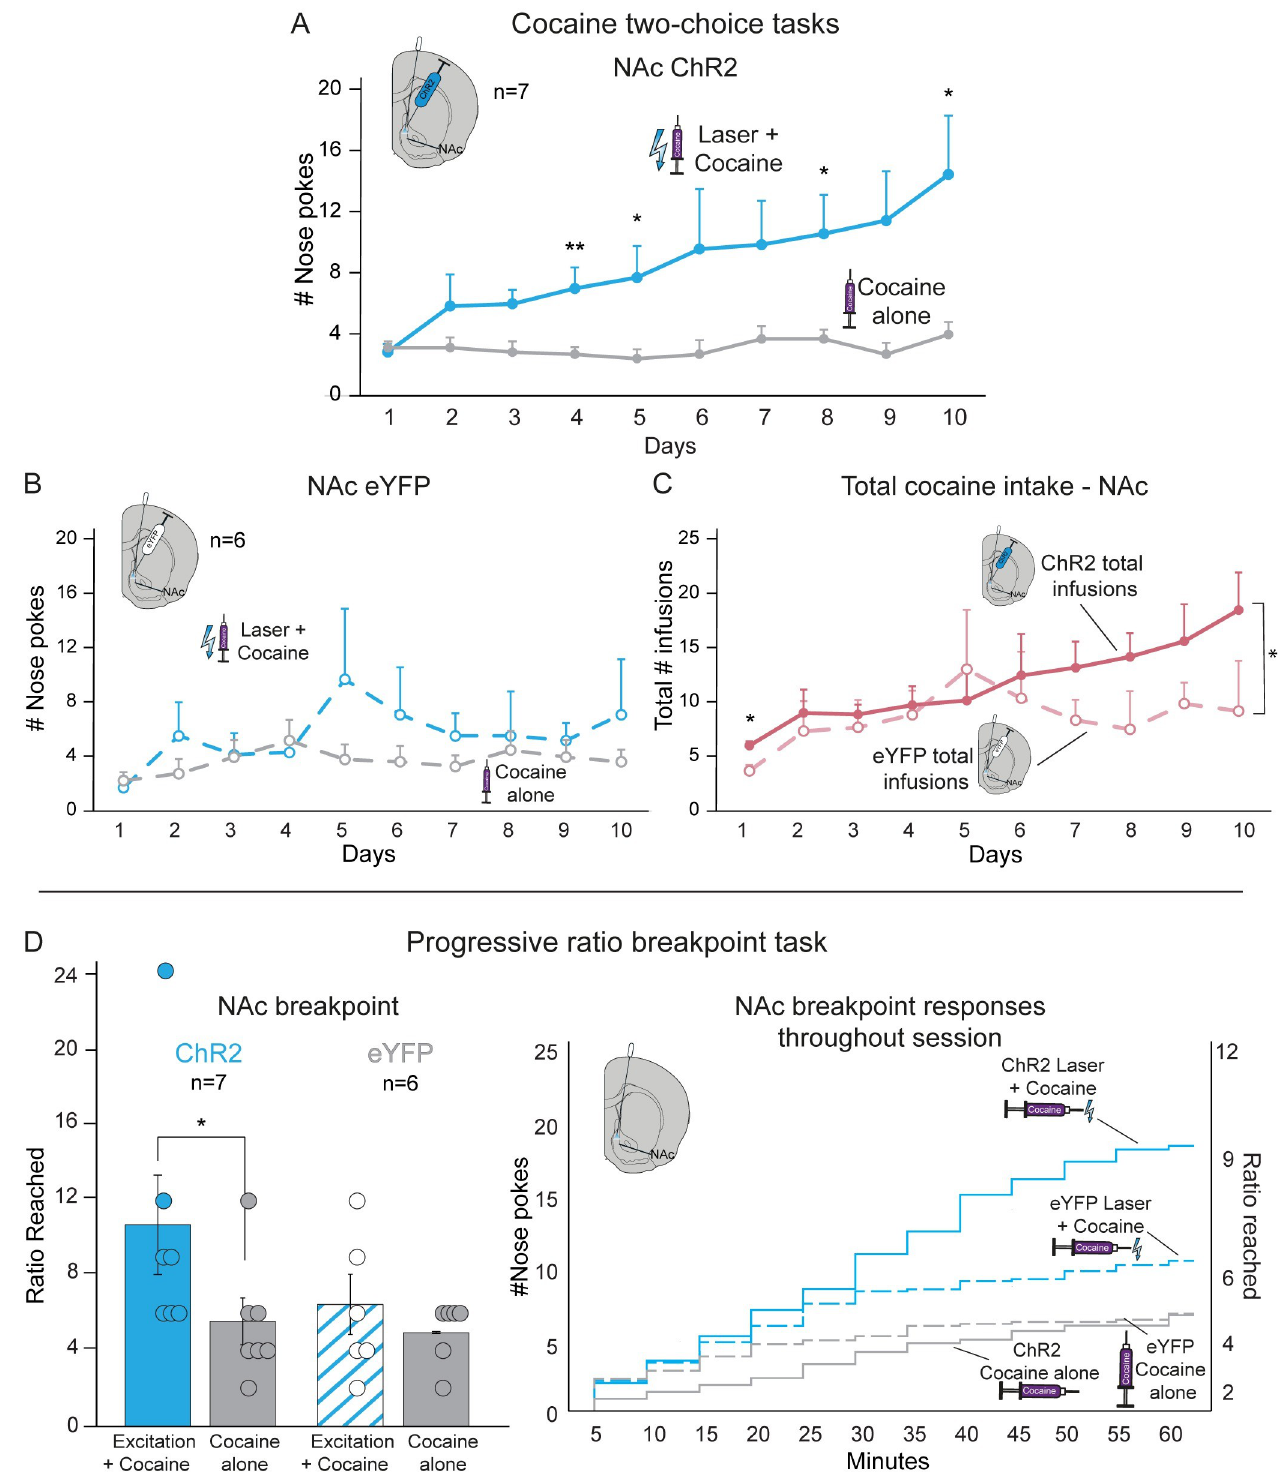
Fig 4. NAc ChR2 stimulation of CRF-containing neurons amplifies motivation and focuses preference on laser-paired cocaine. A) In the two-choice task, ChR2 excitation of CRF-containing neurons in NAc medial shell focused preference and cocaine pursuit on the Laser+Cocaine option by a 4:1 ratio over Cocaine alone in the two-choice task (n = 7). B) In comparison, control NAc eYFP rats chose equally between the two cocaine options (n = 6). C) NAc ChR2 rats also escalated total cocaine intake ( Laser+Cocaine plus Cocaine alone options combined) to higher magnitudes than eYFP controls in two-choice task. D)